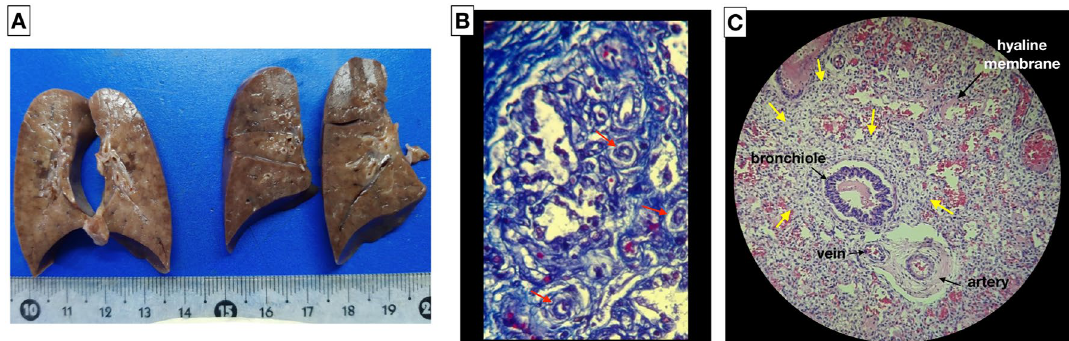
Fig. 3 Macroscopic and histopathological finding of alveolar capillary dysplasia with ACD/MPV. A Macroscopic image and the cut surface of the lungs. Histopathology study: B abnormal capillary pattern (red arrows) in the pulmonary interstitial space (Masson’s trichrome stain); C thickening of the alveolar wall (yellow arrows), irregular capillary vascularization, hypertrophy of the medial layer of the arterioles, abnormal arrangement of the veins adjacent to the arteries and foci of hyaline membranes (hematoxylin and eosin